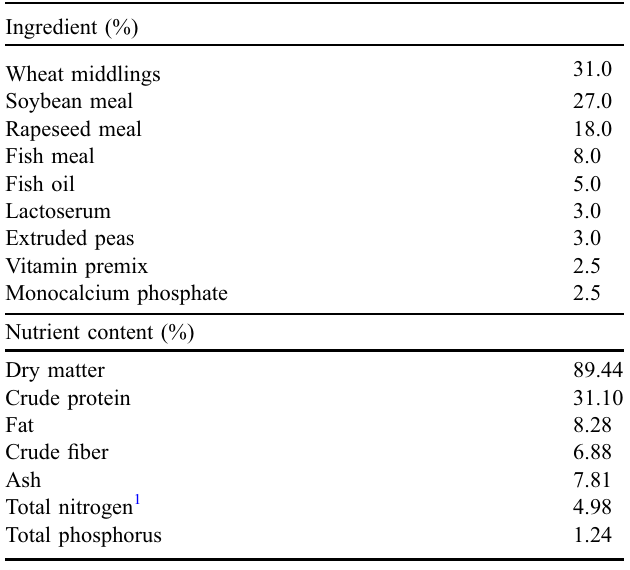
Table 1. Ingredient composition and characteristics of the feed supplied.